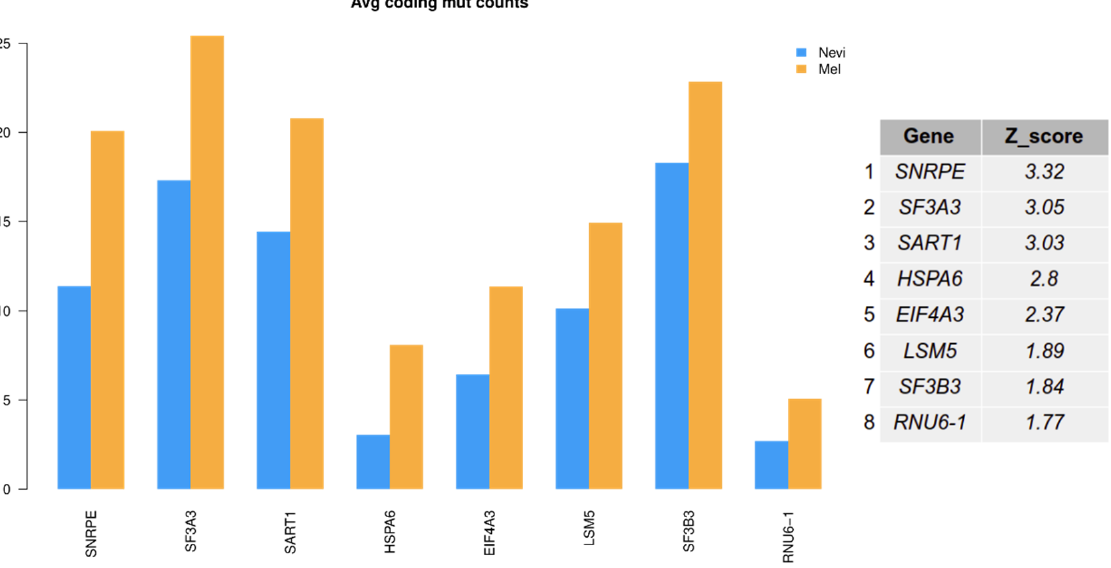
Figure 10. Significance score of mutational load of spliceosomal genes in the comparison of primary melanomas with benign melanocytic nevi. The plot shows spliceosome genes with significant average mutation count difference. Z-score was estimated by constructing a distribution of 200 randomly selected switched isoforms of similar length.